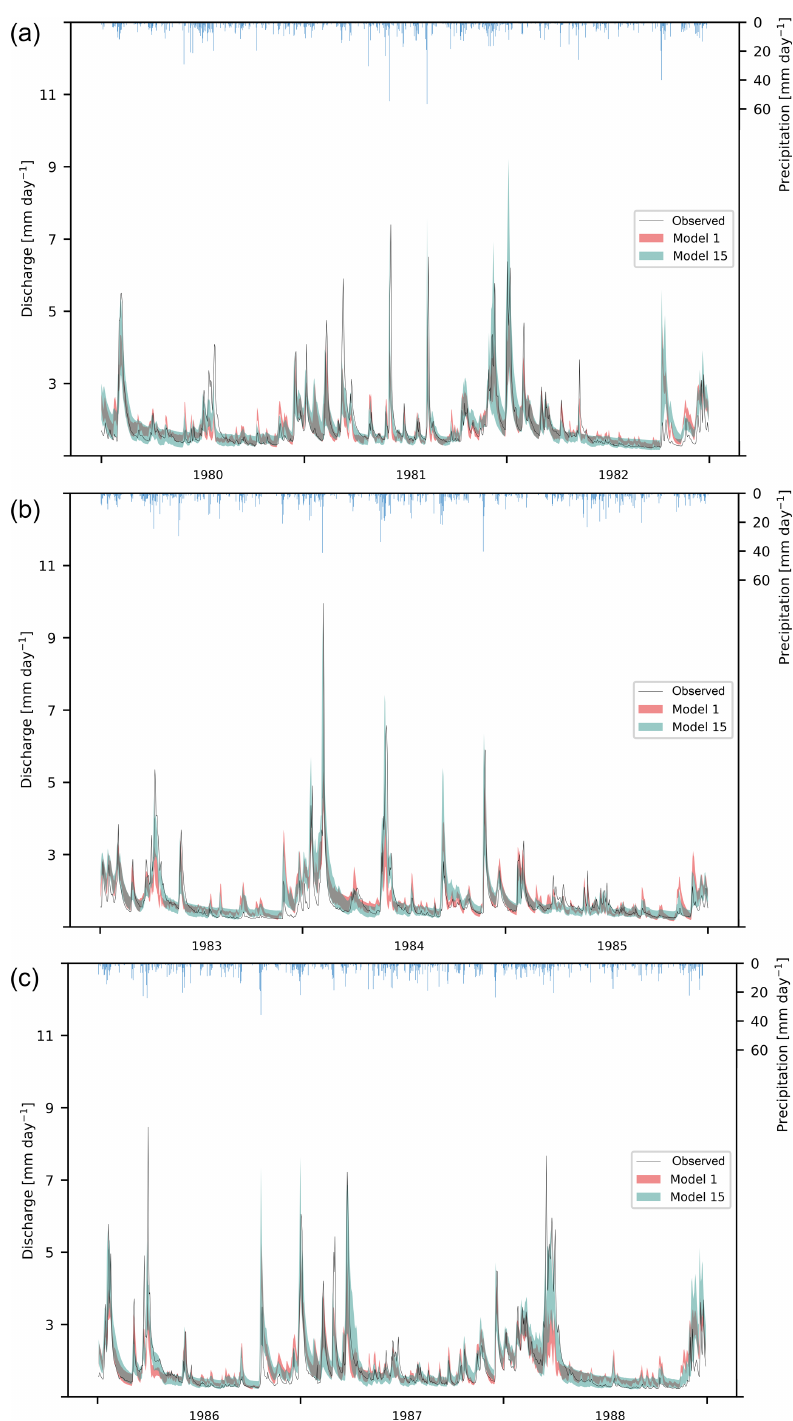
Figure 7. Hydrograph of the Fulda River for 1980–1988. Colored areas depict the range of the behavioral model runs (5th to 95th percentile). Calibration period is from 1980 until 1985 (a, b) . Validation period is from 1986 to 1988 (c) . Observed discharge is depicted as a black line. Precipitation is drawn with an inverted y